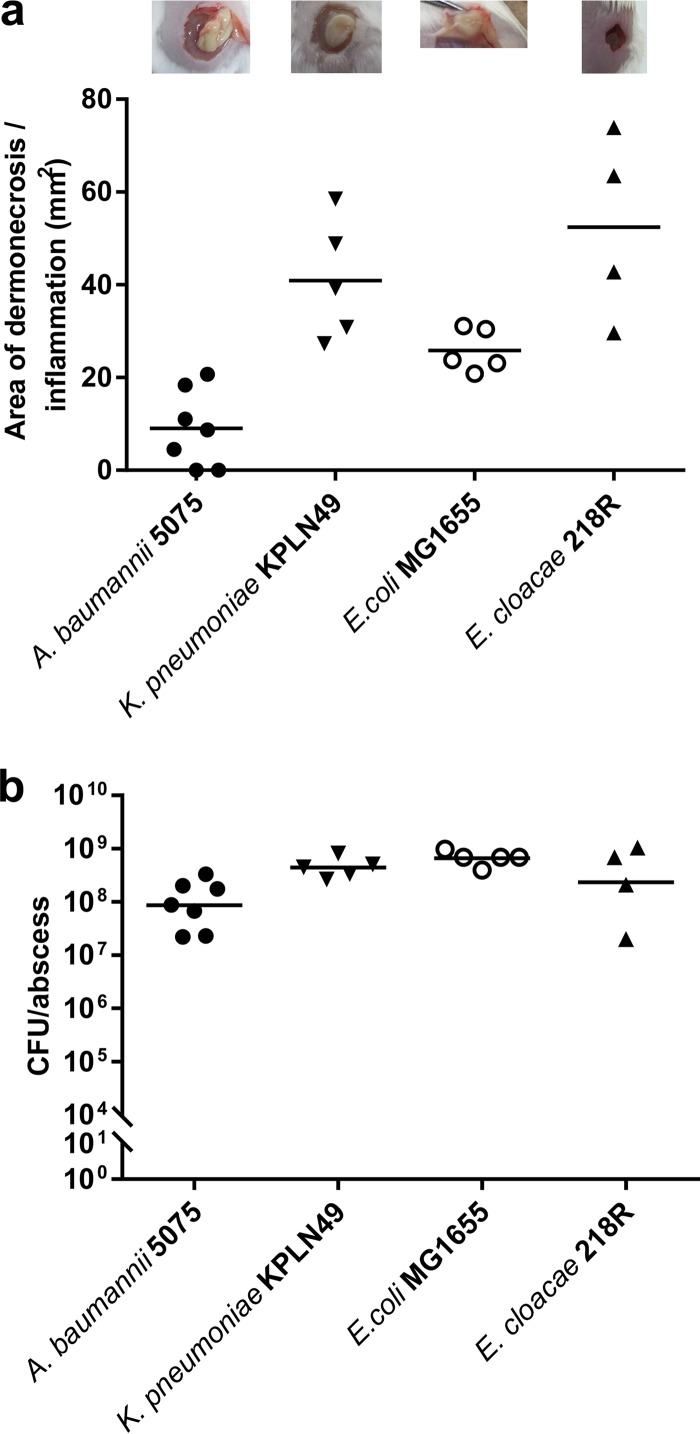
Mouse cutaneous infection with Gram-negative bacteria. CD-1 mice were infected with 5 × 108 CFU A. baumannii AB5075, K. pneumoniae KPLN49, or E. coli K-12 MG1655 as well as with 5 × 107 CFU E. cloacae 218R1. Abscess sizes and CFU counts were determined 3 days postinfection. The experiment was repeated at least twice. (a) Abscess formation and inflammation (i.e., accumulated infiltrate under the skin) showed large pus cavities for A. baumannii, K. pneumoniae, and E. coli, while E. cloacae formed a dry abscess (top panels). Abscess measurements are shown below the top panels. (b) CFU counts/abscess.